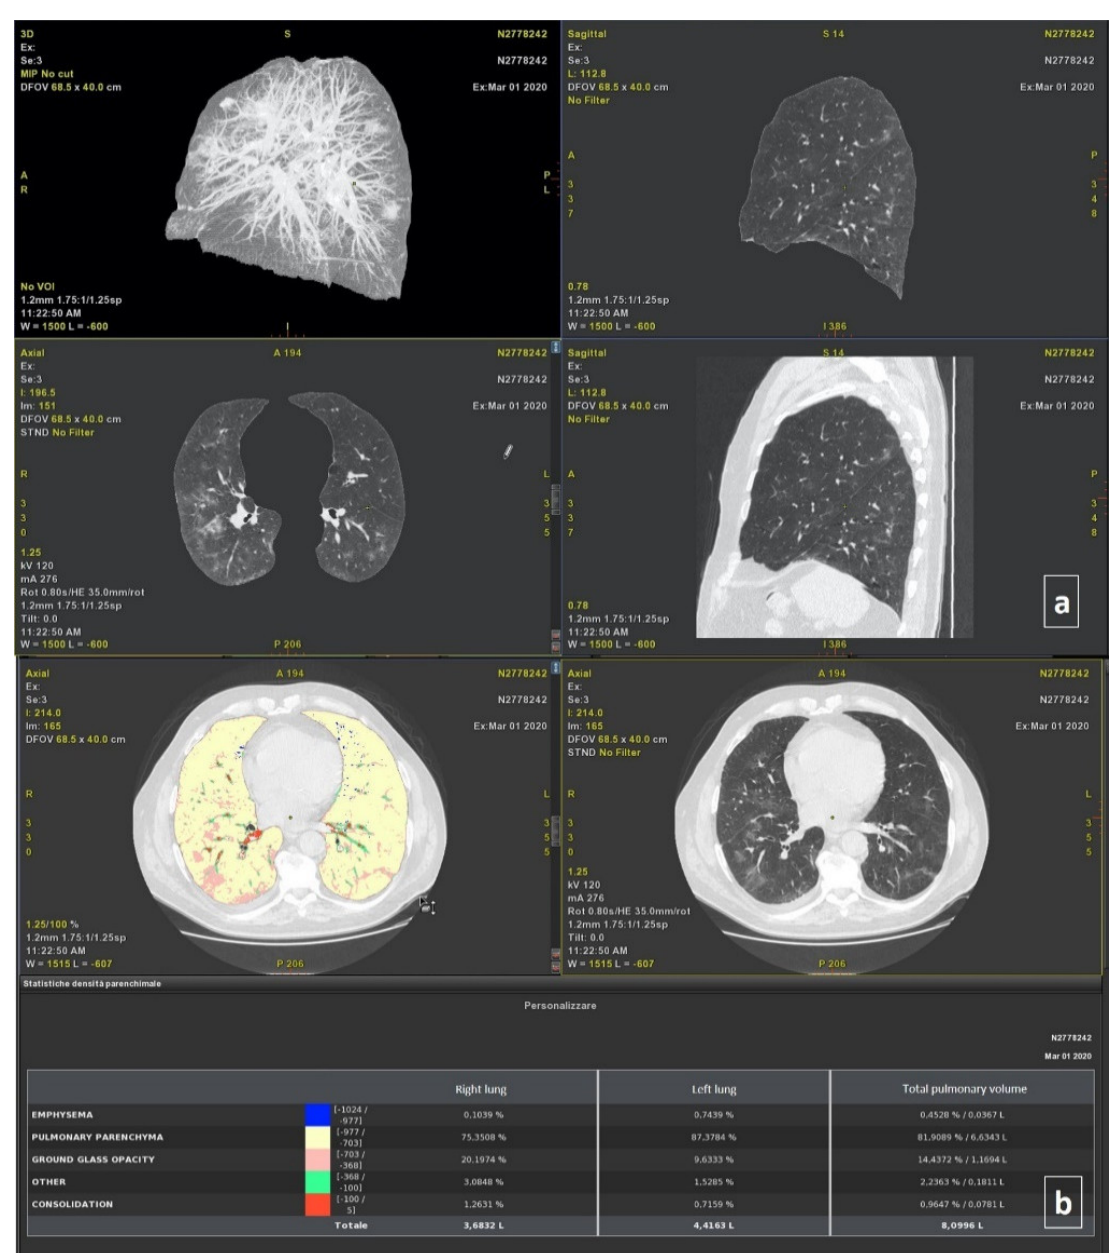
Figure 1. Automatic segmentation of thoracic disease by COVID-19 using the Thoracic VCAR Tool of General Electric Healthcare: ( a ) 3D axial and sagittal plane reconstruction; ( b ) density analysis of parenchyma. This case had bilateral and diffuse, and consolidations in multiple lobes.